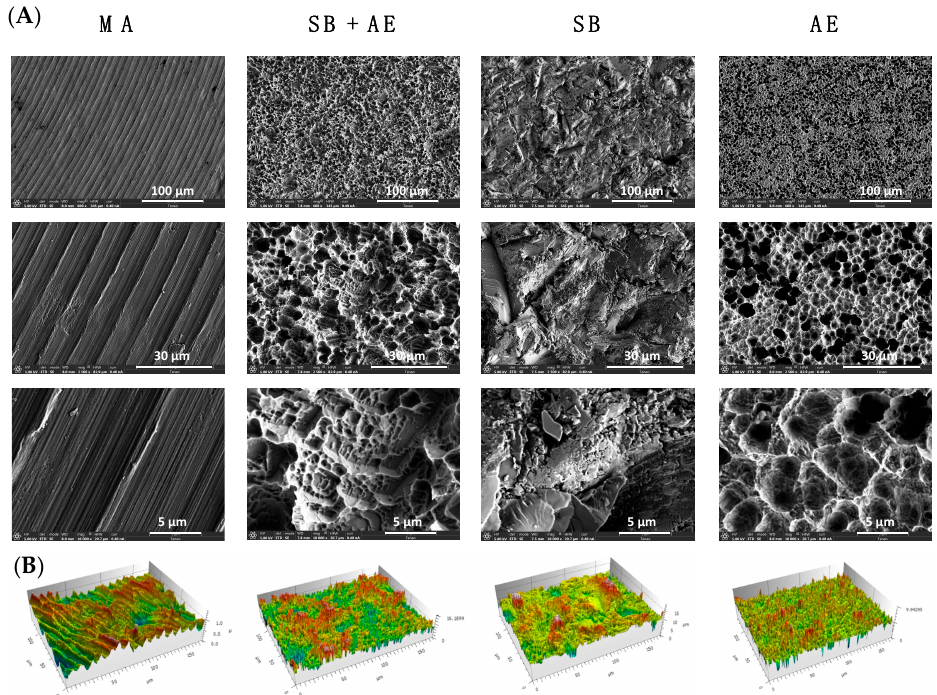
Figure 2. Ti-disc analysis ( A ) by FESEM and confocal scanning of the titanium discs with different surface treatment: mechanical abrasion (MA), sandblasting plus acid etching (SB + AE), sandblasting (SB) and acid etching (AE). Below, 3D representations of the surface analysis by optical profiling ( B ).